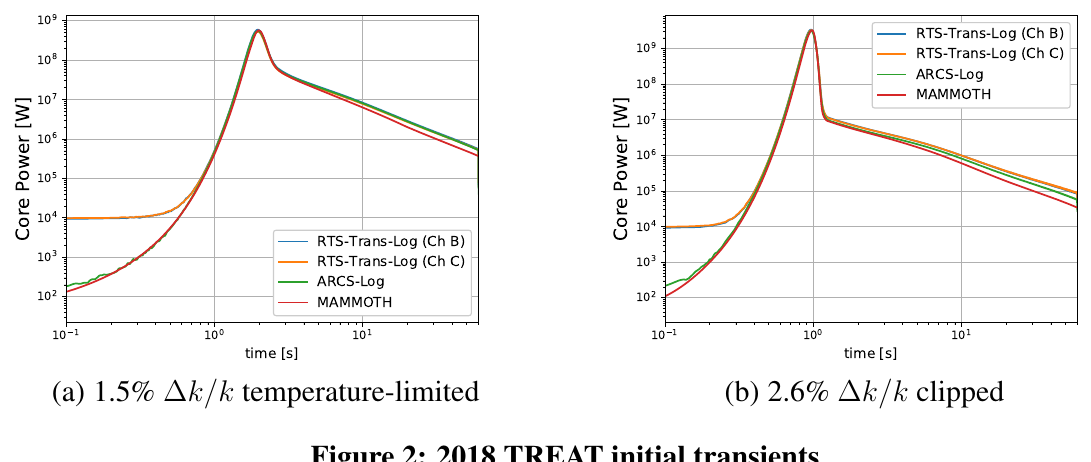
Figure 2: 2018 TREAT initial